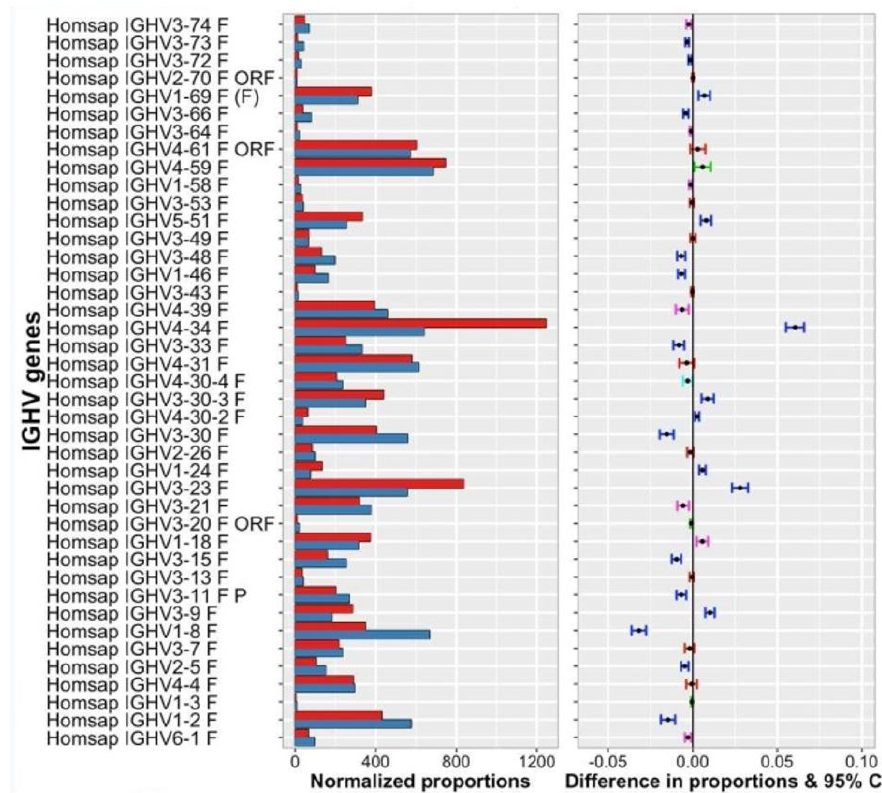
Figure 28. Results of IMGT/StatClonotype [76,77]. Differences in proportions graph. Genes are ordered by their position in the locus with the IMGT functionality [2]. The differences in proportions graph with significance and confidence interval (CI) are shown for Homo sapiens IGH IMGT clonotypes (AA) with a given gene, between two sets of B cell populations. Negative differences in proportions are shown on the left of the vertical line (abscissa equal to 0) and positive differences are shown on the right of the vertical line. CI bars colors correspond to the test interpretation before adjustment of p ‐ values, red (non ‐ significant) and cyan (significant) (rawp), significant differences validated by the IMGT/StatClonotypes seven procedures (All_p): dark blue, by two or more multiple testing procedures (Min_2p): pink, and only by Benjamini & Hochberg (BH) (Only_BH): green). (With permission from M ‐ P. Lefranc and G. Lefranc, LIGM, Founders and Authors of IMGT ® , the international ImMunoGeneTics information system ® , http://www.imgt.org).